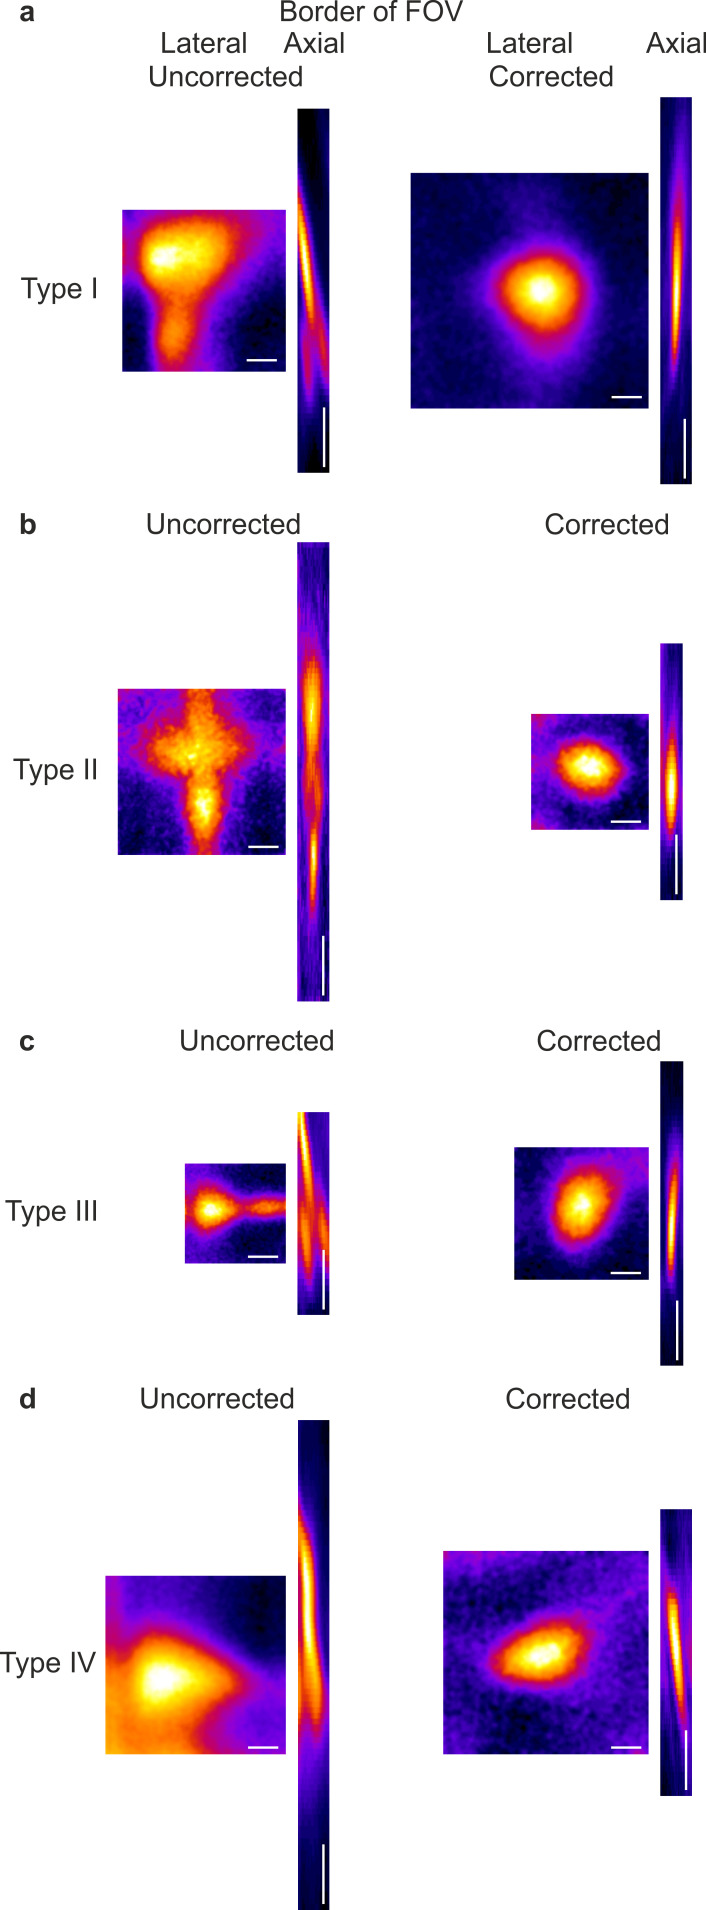
Aberration correction improves the PSF in the peripheral portions of the FOV in eFOV-microendoscopes.(a) Lateral and axial projection of a z-stack of a subresolved fluorescent bead positioned at the border of the FOV and imaged with the uncorrected (left) and corrected (right) type I microendoscopes. Scale bars: 1 µm (lateral), 10 µm (axial). (b) Same as in (a) for type II microendoscopes. (c) Same as in (a) for type III microendoscopes. (d) Same as in (a) for type IV microendoscopes. Please note that the slight tilt of the axial PSF with respect to the optical axis in corrected microendoscopes reflects the curvature of the distal conjugated optical plane, as visible in Figures 1 and 3 (non telecentric optical system).